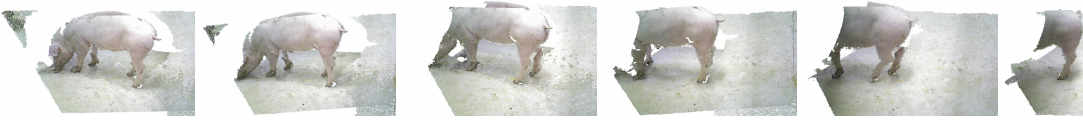
Figure 9. Visualisation of point cloud sequences capturing in pig farm.